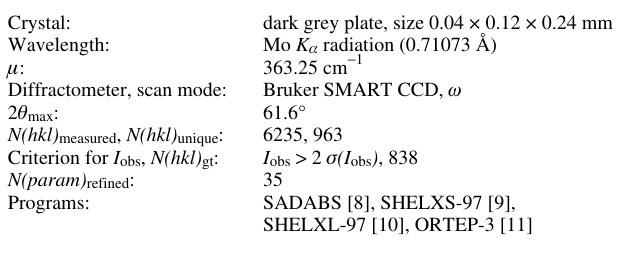
Table 1. Data collection and handling.